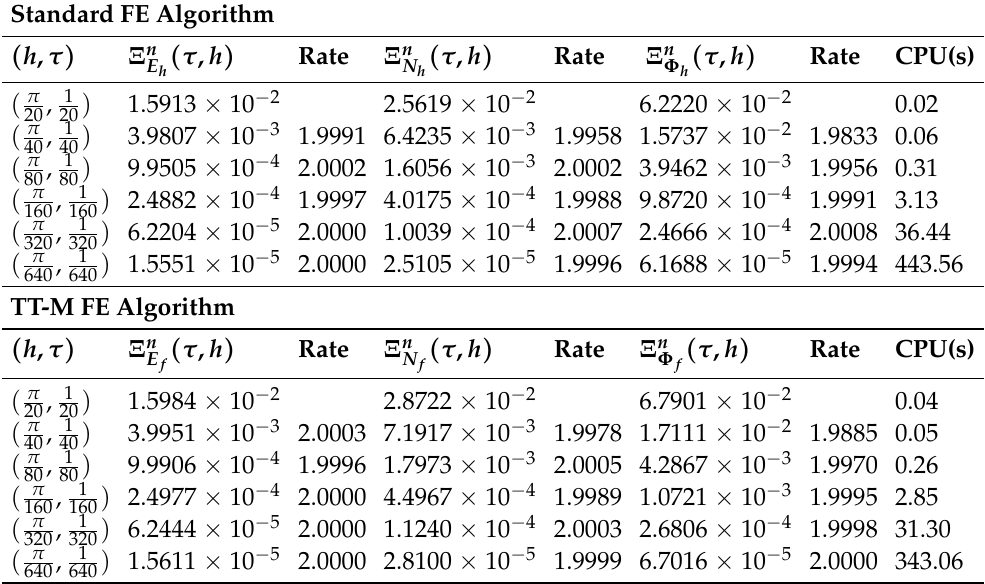
h and τ C = 4 τ π